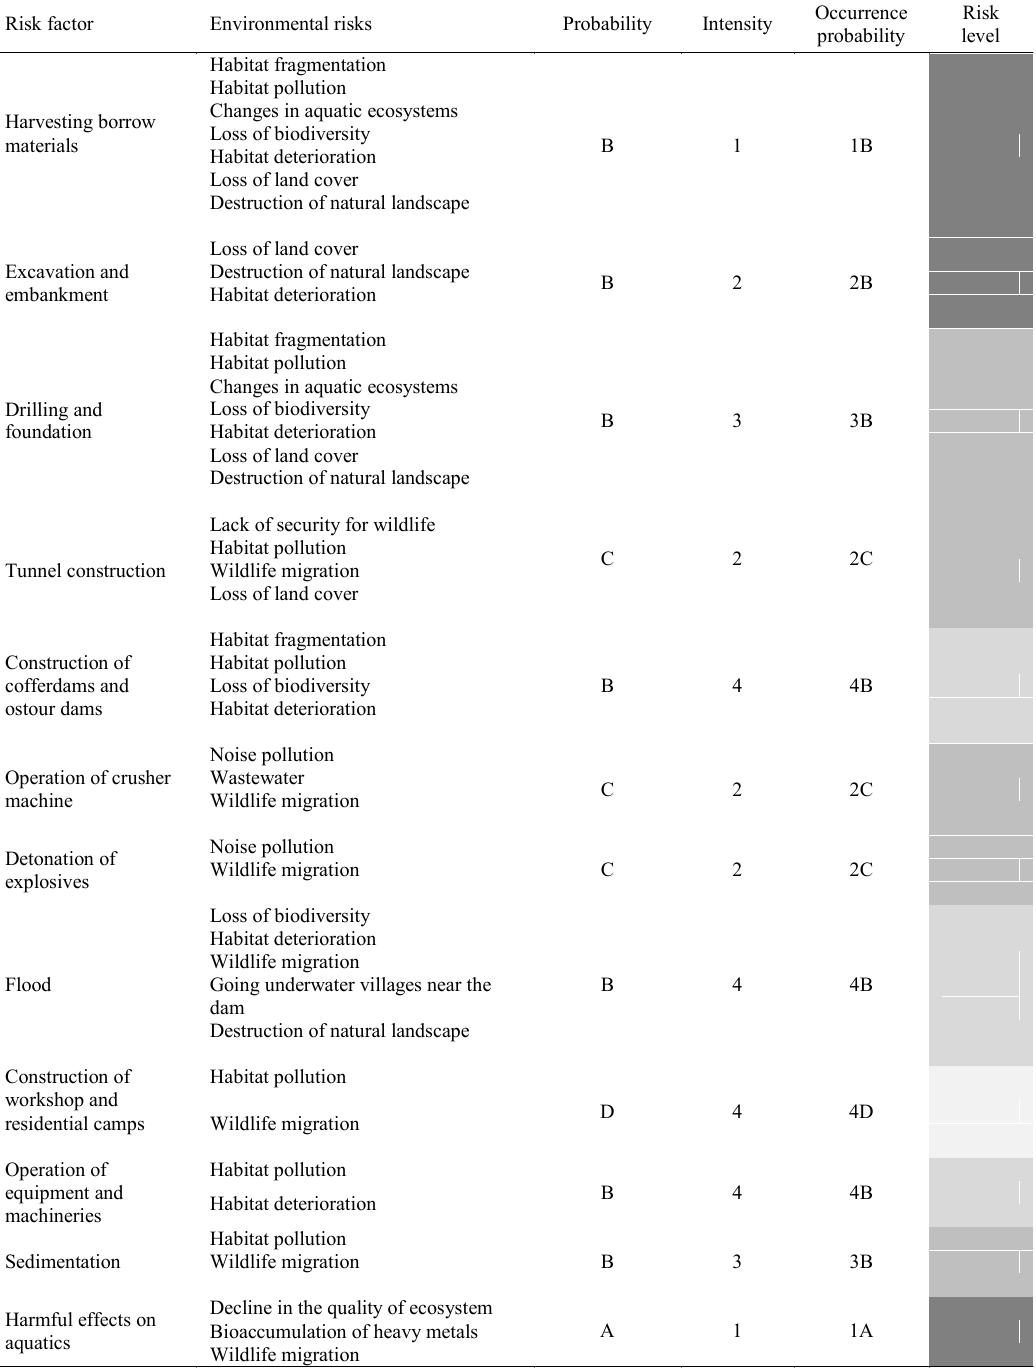
Table 11: Ranking of risks by